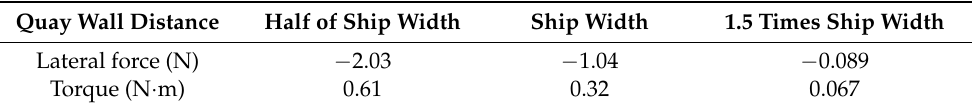
Table 3. Law of ship hull force changing with quay distance when the speed is 3 m/s. Quay Wall Distance